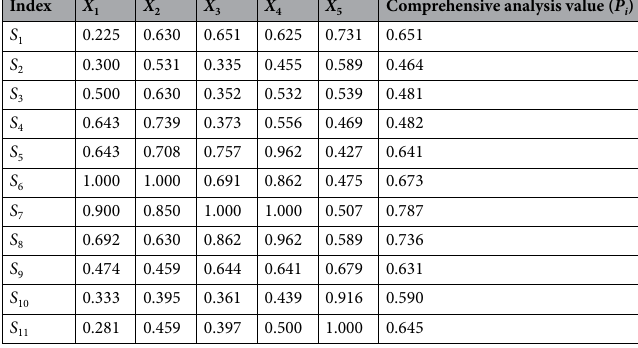
Table 2. Grey close function value and the comprehensive analysis